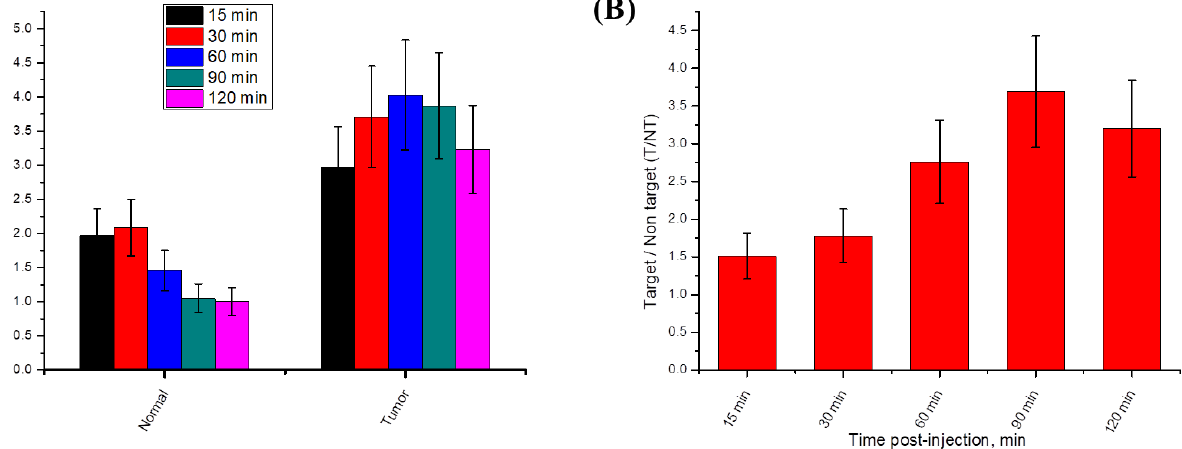
Figure 9. ( A ) Percent injected dose per gram organ of normal and tumor muscles and ( B ) target/non- target ratios of radioiodinated- 4i in sarcoma-bearing mice model.